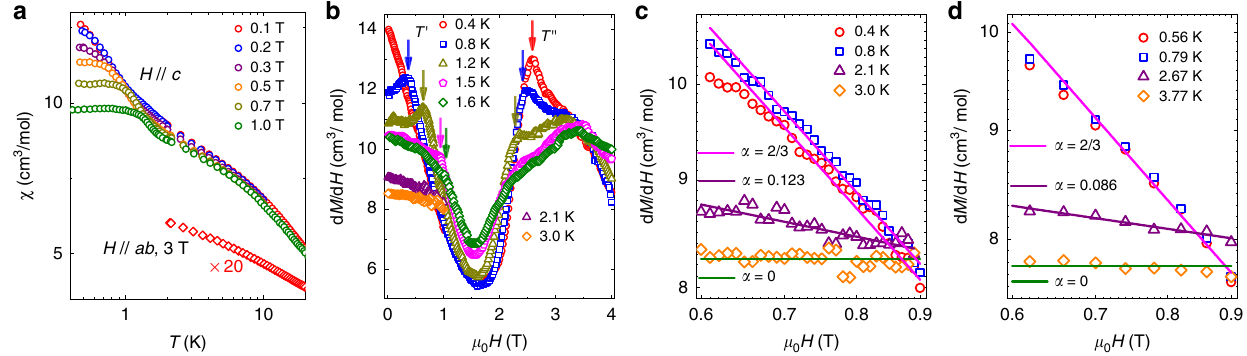
Fig. 3 Uniform magnetic susceptibility of TmMgGaO 4 and scaling analysis. a dc susceptibility χ as functions of temperatures under small out-of-plane ( H // c ) and in-plane ( H // ab ) fi elds. The latter is multiplied by a factor of 20 for visualizing purpose. The deviation of data below 2 K indicates the entry to the BKT phase and the fi eld-suppression of magnetic correlations. b The differential susceptibility dM / dH under out-of-plane fi elds at different temperatures. The kinks at low fi elds, as denoted by the down arrows, suggest the transition from the BKT-like phase to the ordered phase (under the dome in Fig. 1) with increasing fi elds. The peaked features at high fi elds suggests a quantum phase transition to the polarized phase. c Fits of dM / dH to the power-law scaling function dM / dH ~ H − α with α = 2/3 for the 0.4 and 0.8 K data, and α = 0.123 for 2.1 K data in the log-log scale. The 3 K data follow the α = 0 line in the paramagnetic phase. d dM / dH by the QMC calculations in the same fi eld and temperature range as in c , and fi ts to the power-law function with exponents α , which give consistent results as